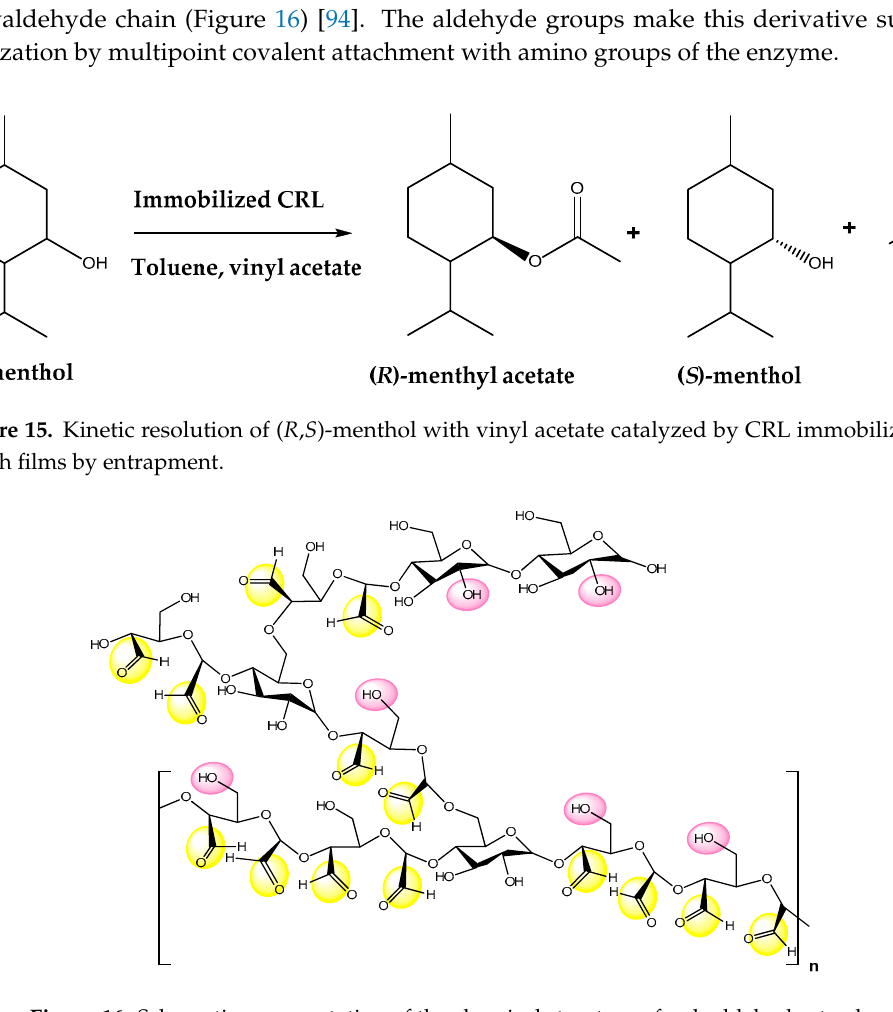
Figure 16. Schematic representation of the chemical structure of polyaldehyde starch .